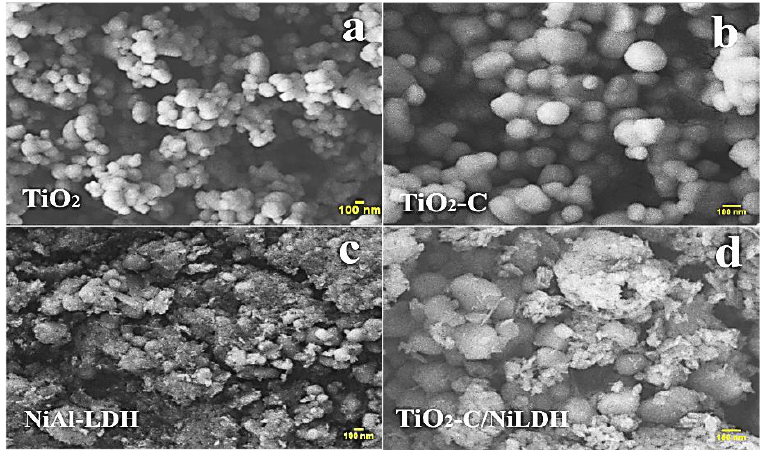
Figure 4. SEM images of ( a ) TiO 2 , ( b ) TiO 2 -C, ( c ) NiAl-LDH and ( d ) TiO 2 -C/NiLDH amalgam.